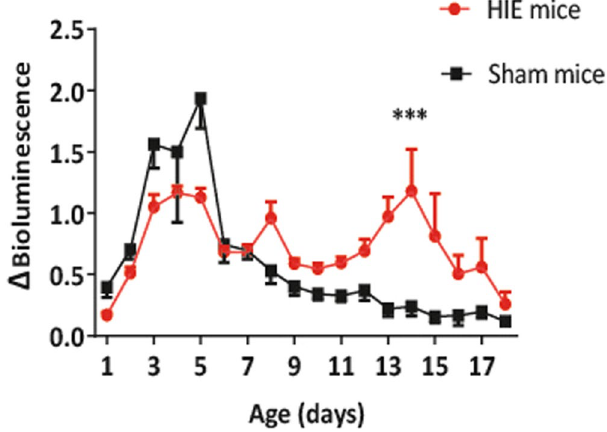
Figure 8. Whole-body conscious bioluminescence imaging of HIE and sham mice pre- and post-surgery. VSV-G pseudotyped NF κ B biosensor was administered at birth to neonatal mice via intracranial injections (n = 22). Conscious whole-body bioluminescence imaging was conducted pre and post-surgery. The mice were split into two groups, HIE mice (n = 13) and sham control mice (n = 9). At P7 of development the HIE mice received surgery and both sets of mice were imaged daily until P19. There was a significant difference in fold change of luciferase expression between the HIE and sham mice over development (mean + / − SD, P < 0.0001). The fold change was specifically seen to be significantly higher (mean + / − SD, P < 0.001) between P14 and